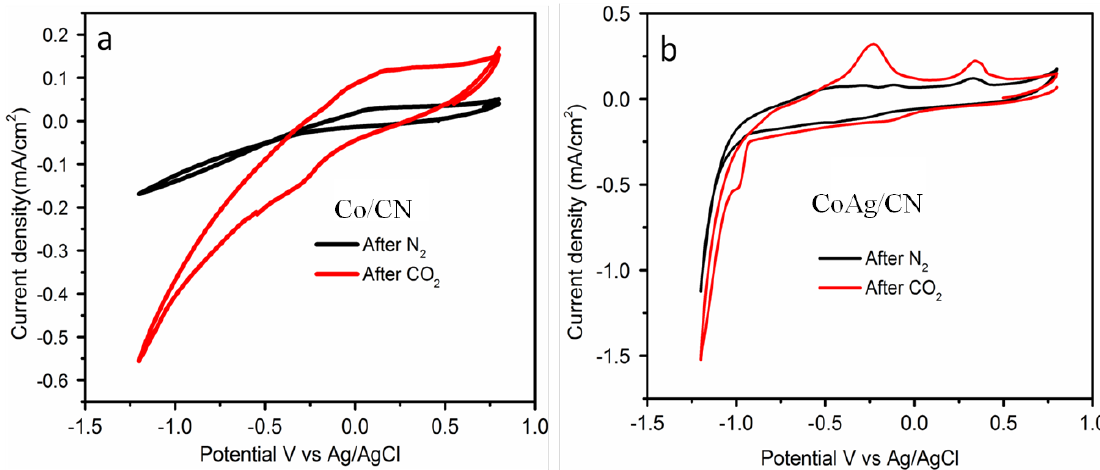
Figure 8. ( a ) CV of Co/CN in 0.5 M KHCO 3 after N 2 and CO 2 purge ( b ) CV of CoAg/CN in 0.5 M KHCO 3 after N 2 and CO 2 purge.